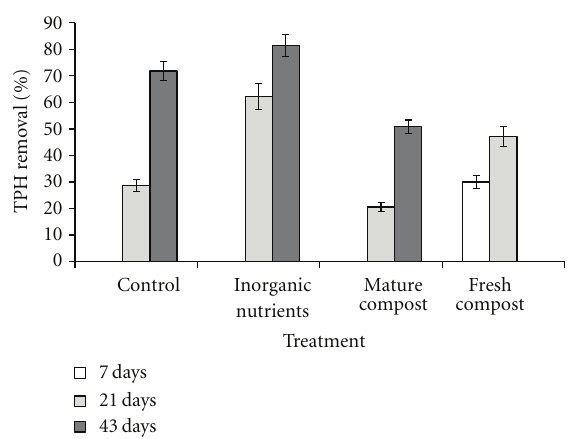
Figure 1: Percentages of TPH removal in the single-step experi- ments in aerobic conditions after 7, 21, and 43 days of treatment.